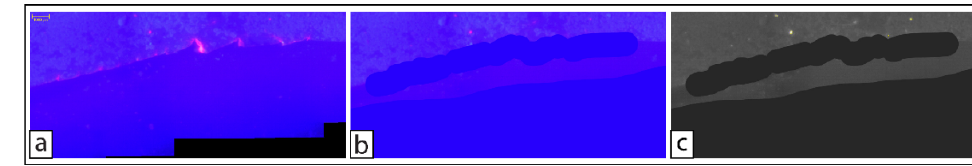
Figure 7. Filter correction using the brush tool. ( a ) Original image from Autostitch; the pink spots are filter portions accidentally dyed by the Nile red solutions and are quite common in the clipped segment of the filter. ( b ) Color image after correction. ( c ) The final output from ImageJ (red channel).